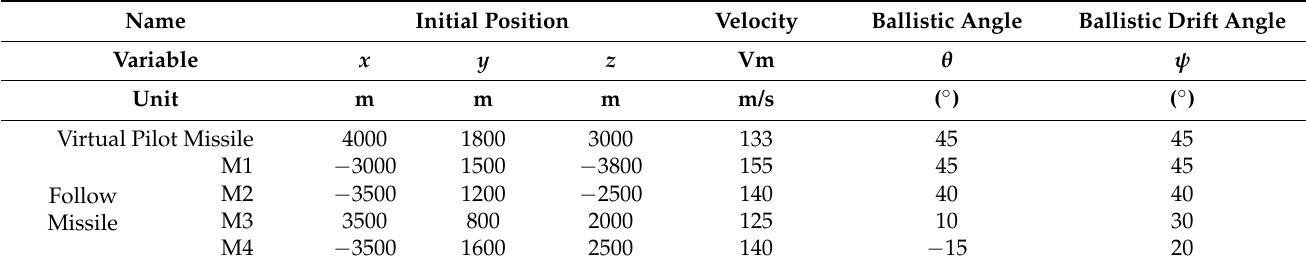
Table 1. Initial parameters of the virtual leader and the follower missiles.